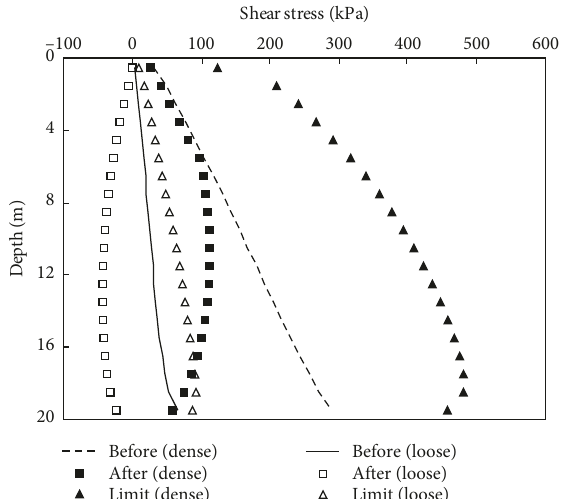
Figure 16: Distribution of shear stress at the pile-soil interface for the restrained head pile.